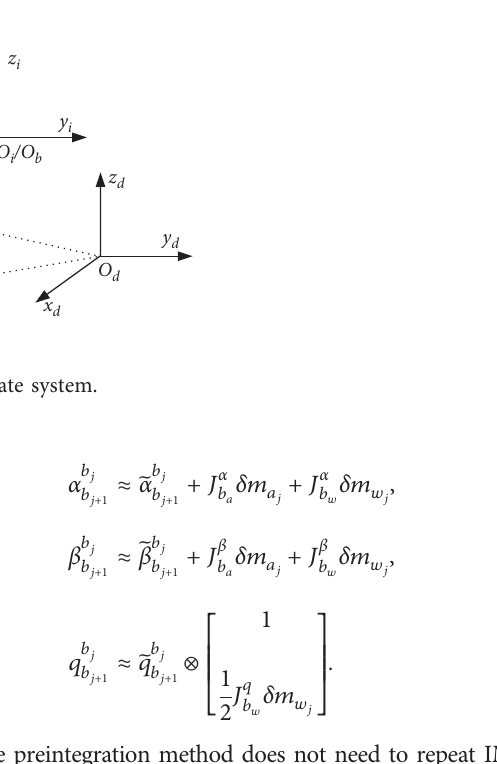
Figure 1: The overall system block diagram.